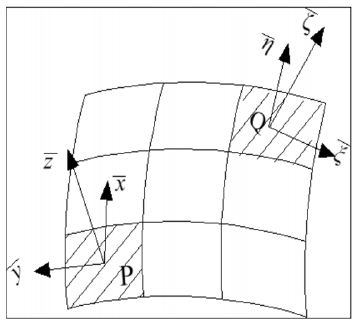
Figure 3. Local coordinate system on the discrete panel.